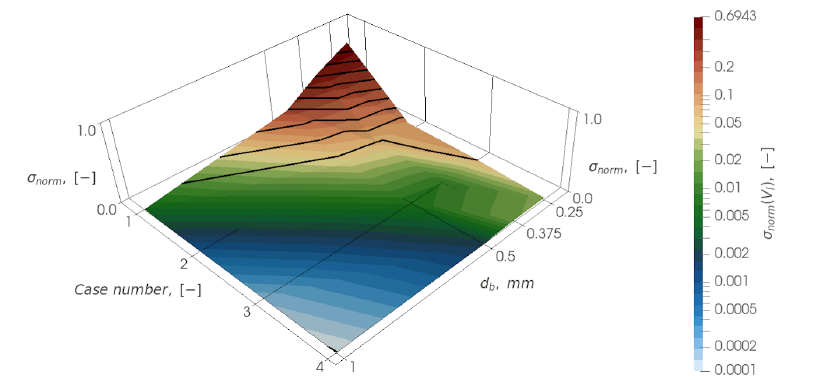
Figure 11. Distribution of a weighted variance σ norm for the liquid velocity, V l